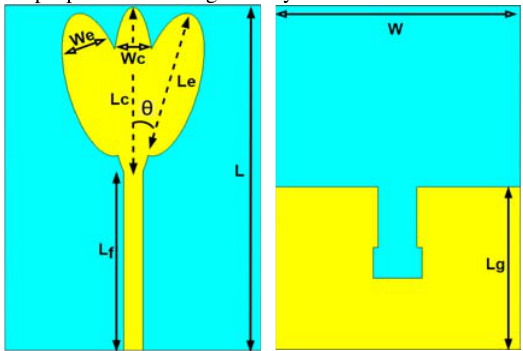
Fig. 2. Geometry of the proposed antenna (a) Top View (b) Botton